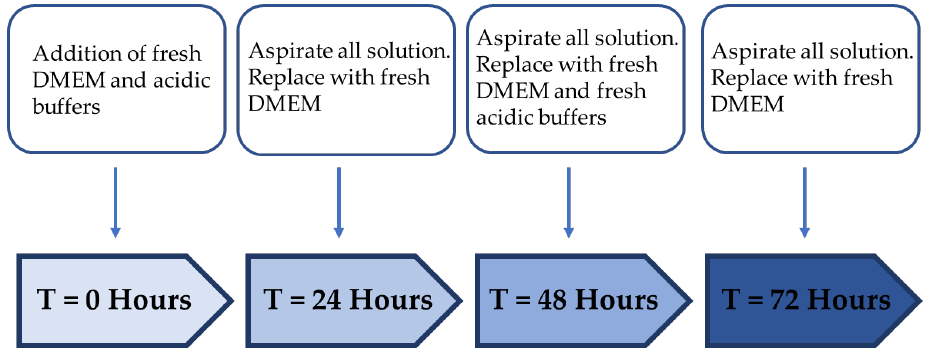
Figure 9 . An example of the experimental protocol for treatment regimen C, indicating 24 h of treatment followed by a 24 h resting period.